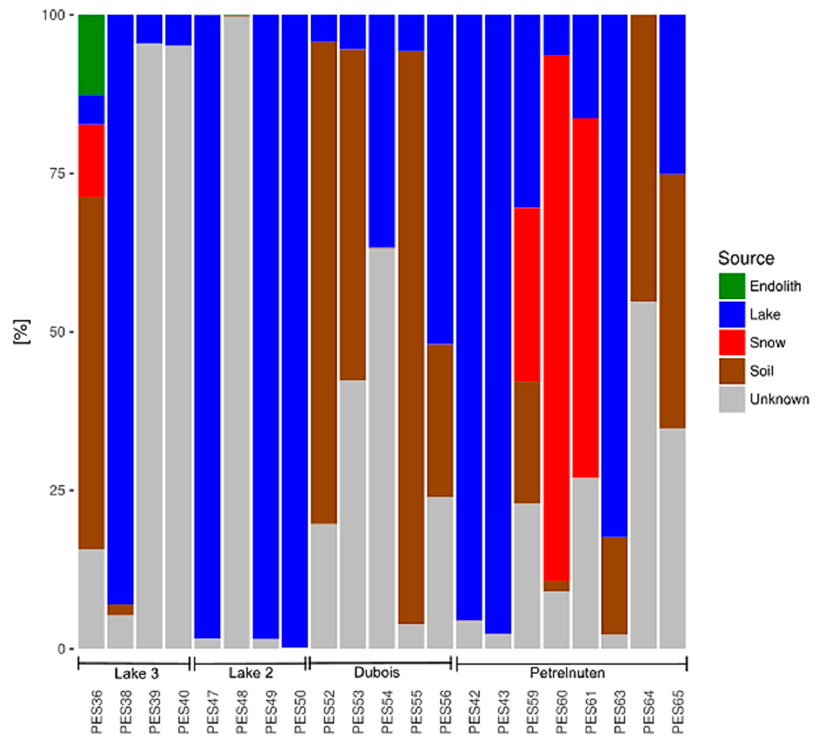
Figure 7. The relative contributions of the habitats endolith/rock, lake, snow and soil as potential sources for the composition of the eukaryotic community in the cryoconite hole samples, as well as the proportion from other (unknown) sources. The distribution of the potential sources does not follow any trends within the four sampling locations and seems to be randomly distributed.